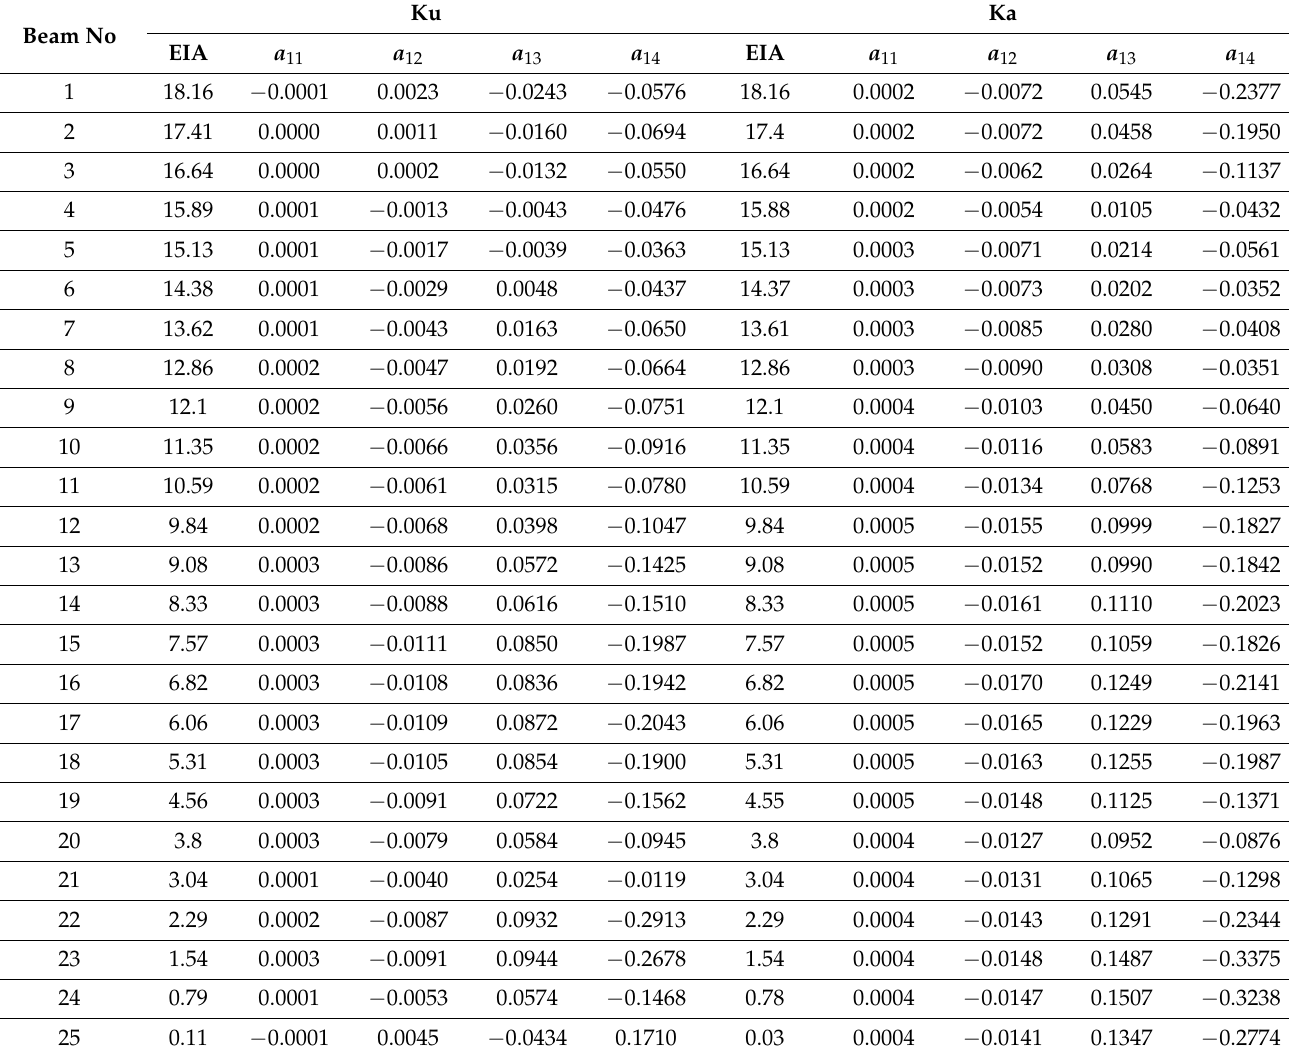
Table A2. Polynomial coefficients for Ku- and Ka-band A 1 model in dB (Equation